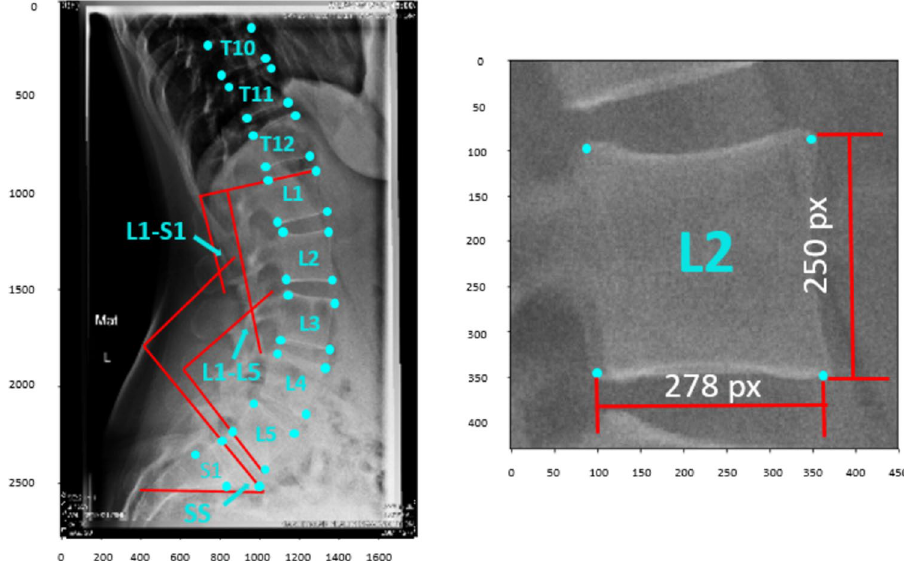
Figure 8. On the left an image of the spine with corners and lumbar angles. On the right a single vertebra with the x and y dimensions in pixel.